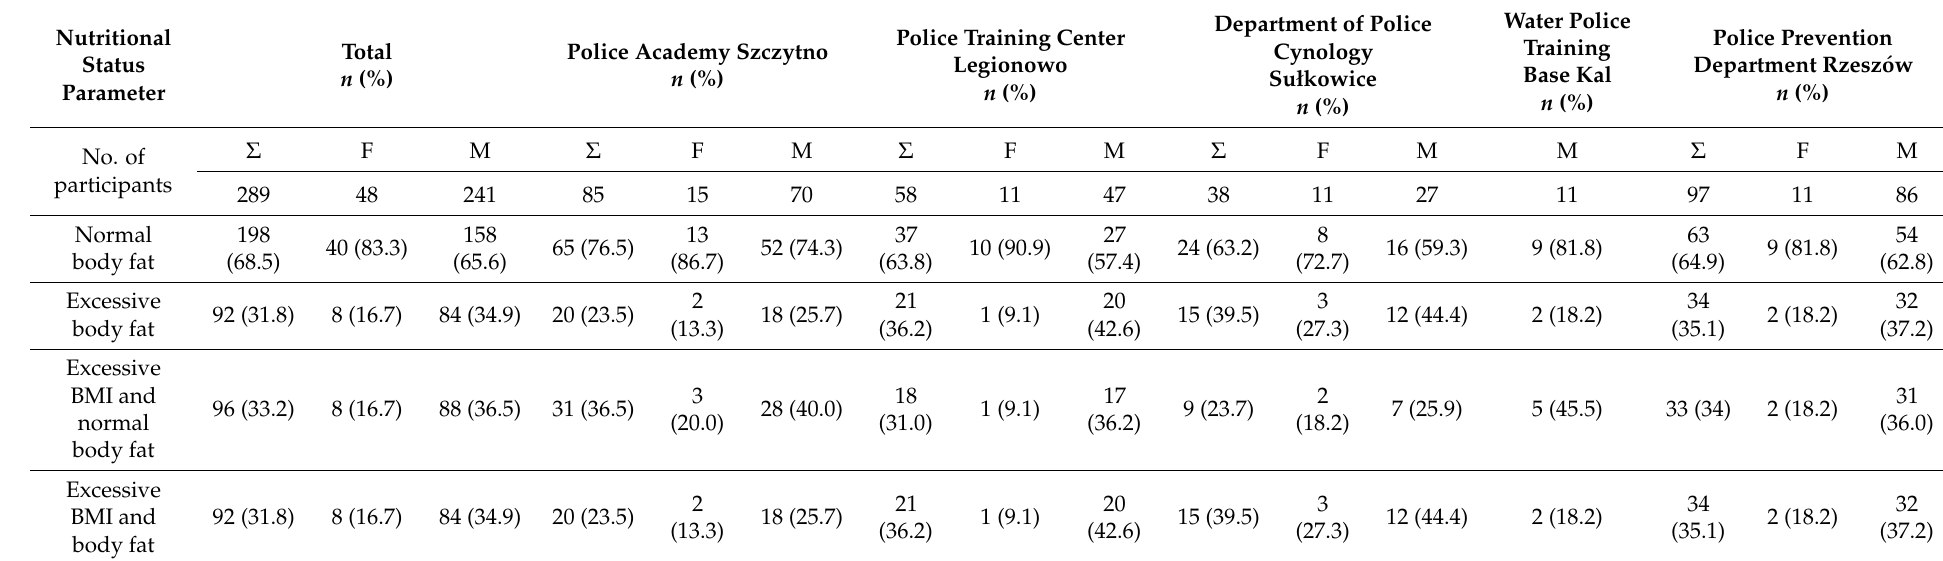
Table 4. Assessment of the nutritional status of police officers based on the fat